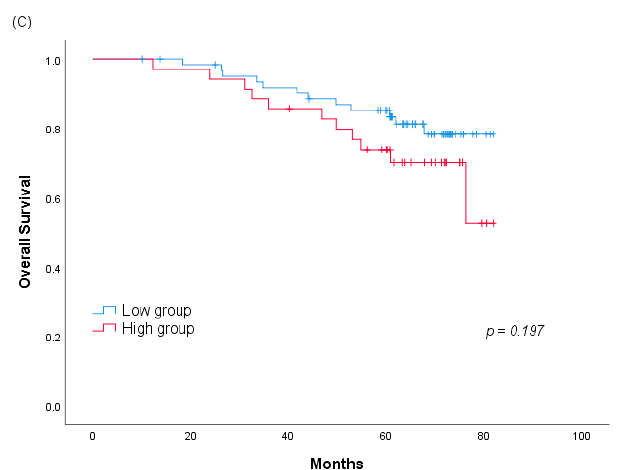
Figure 3. Difference in the 60-months overall survival between the high and low groups according to the serum GPx3 change ( A ) at 3, ( B ) 6 and ( C ) 12 months. Abbreviation: GPx3, glutathione peroxidase 3.